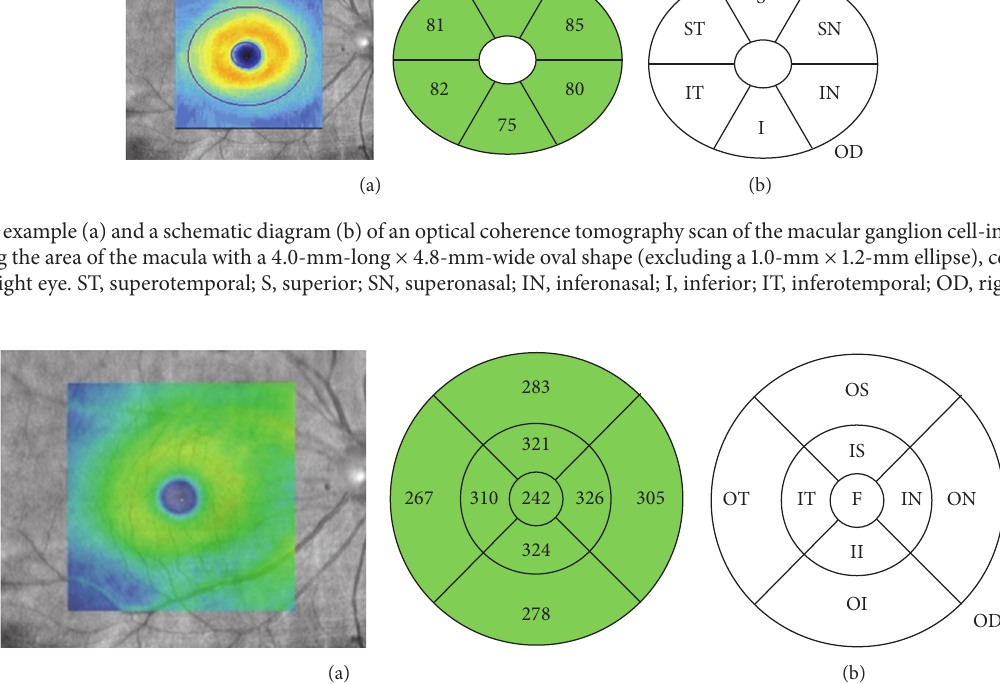
Figure 4: An example (a) and a schematic diagram (b) of a macular optical coherence tomography (OCT) scan showing areas of the fovea with a 1.0-mm concentric diameter, the inner macular area with a 3.0-mm concentric diameter, and the outer macular area with a 6.0-mm concentric diameter. The numbers refer to the average thickness of each macular sector. F, fovea; S, superior; IS, inner superior; OS, outer superior; IN, inner nasal; ON, outer nasal; II, inner inferior; OI, outer inferior; IT, inner temporal; OT, outer temporal; OD, right